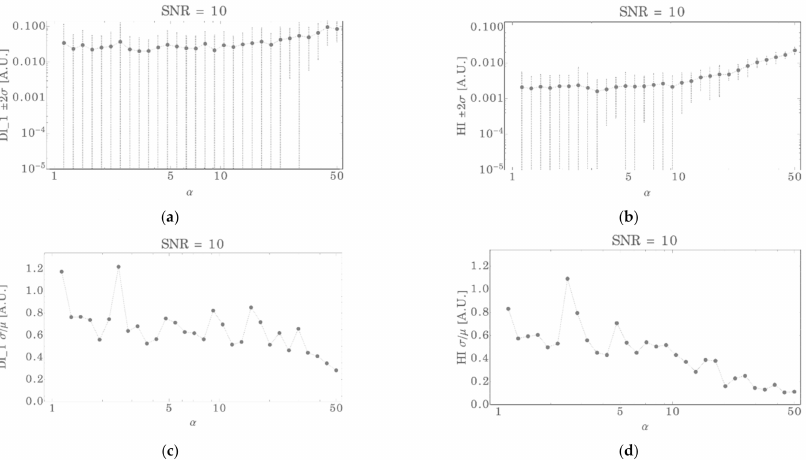
Figure 6. Mean value and standard deviation ( ± 2 σ ) of the estimators depending on the amount of damage α . ( a ) Double logarithmic scale representation of damage indicator DI 1 @ SNR = 10 dB; ( b ) double logarithmic scale representation of the proposed damage indicator HI @ SNR = 10 dB;